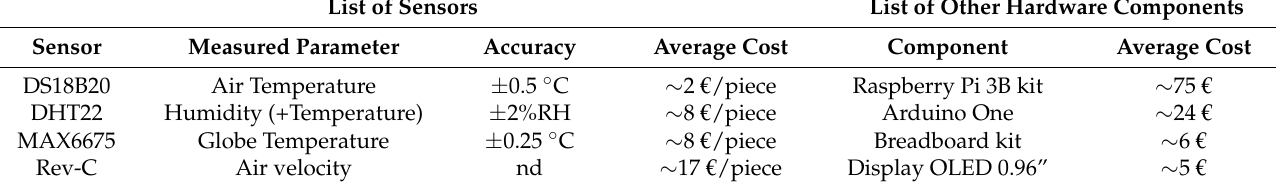
Table 1. Hardware kit